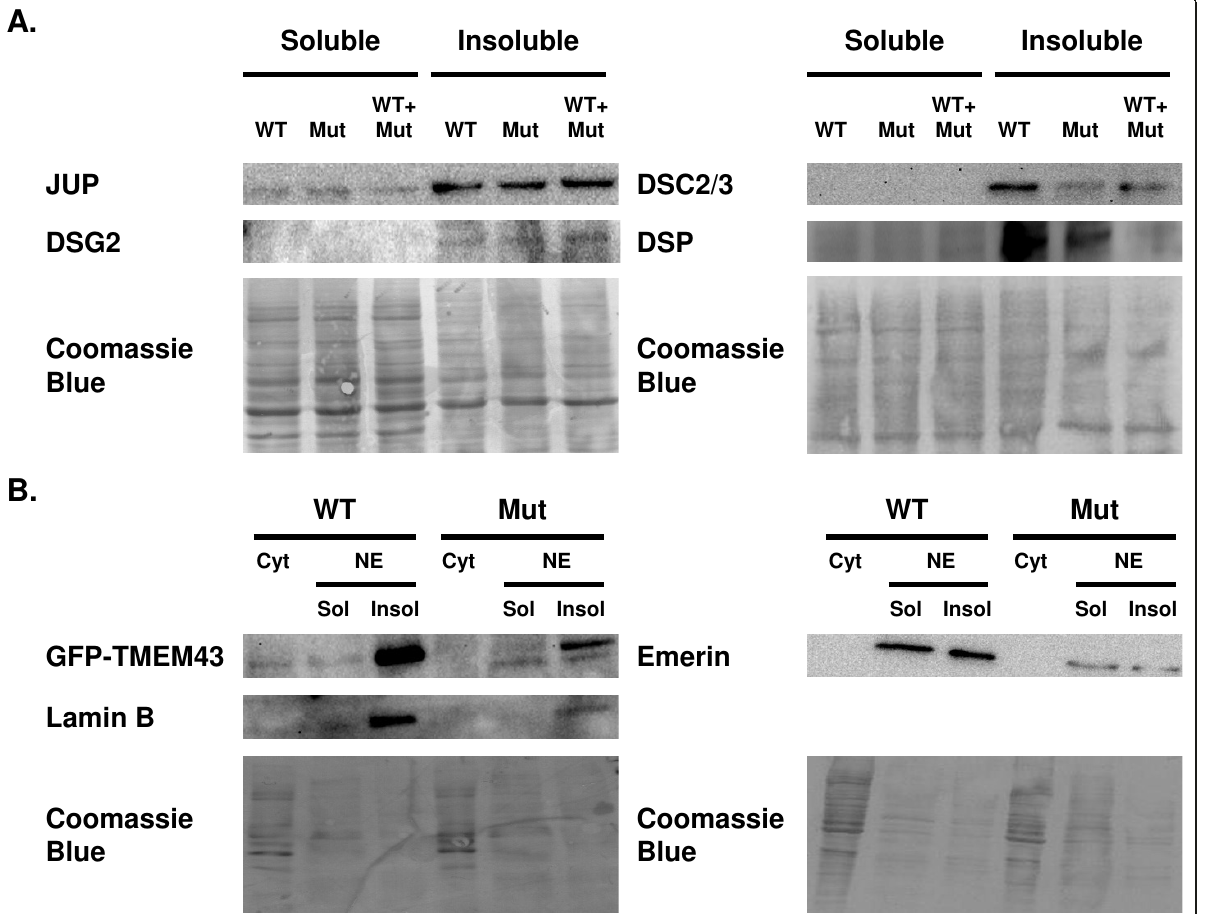
Figure 2 Solubility assays . Solubility patterns for (A) desmosomal and (B) nuclear envelope proteins were assessed by immunoblots for soluble and insoluble protein fractions extracted from COS-7 cells transfected with wildtype (WT) TMEM43 , mutant (Mut) TMEM43 , or a 1:2 ratio of wildtype to mutant (WT + Mut) TMEM43 . Sol, soluble fraction containing cytoplasmic (Cyt) proteins; Insol, insoluble fraction containing membrane bound proteins. No differences in solubility patterns were found, suggesting that the presence of mutant TMEM43 did not alter the stability of TMEM43 or of other desmosomal or nuclear envelope